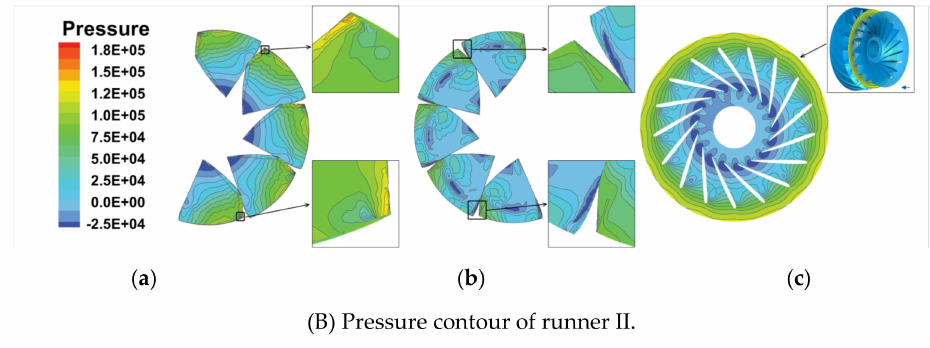
Figure 12. Pressure contour of runner blade and runner flow channel under PLP (a 8 = 77 mm). ( a ) Pressure side of blade; ( b ) suction side of blade; ( c ) runner flow channel.